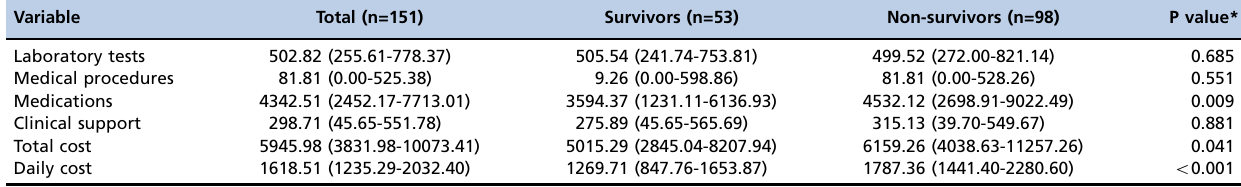
Median data (interquartile deviation) *Mann-Whitney